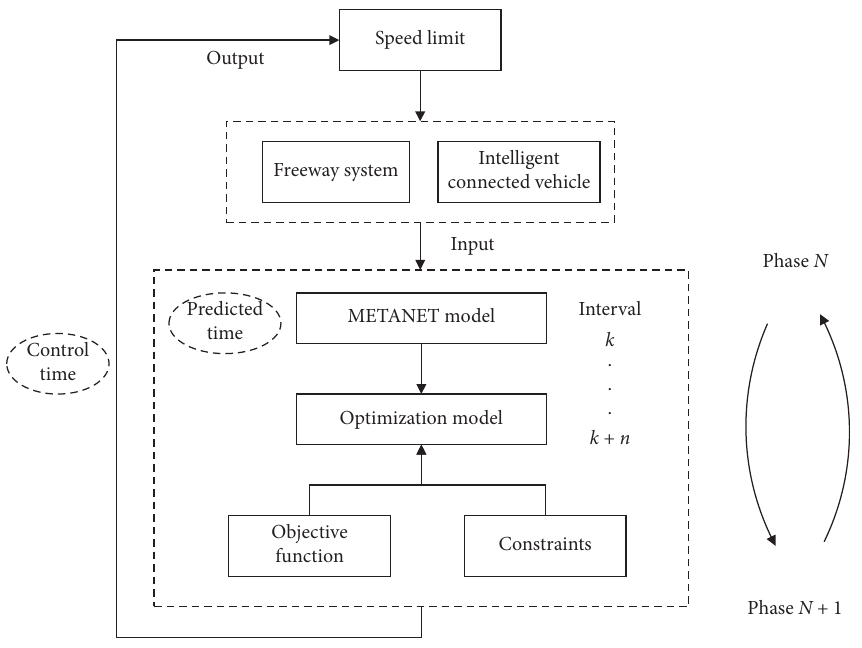
Figure 2: Control flow